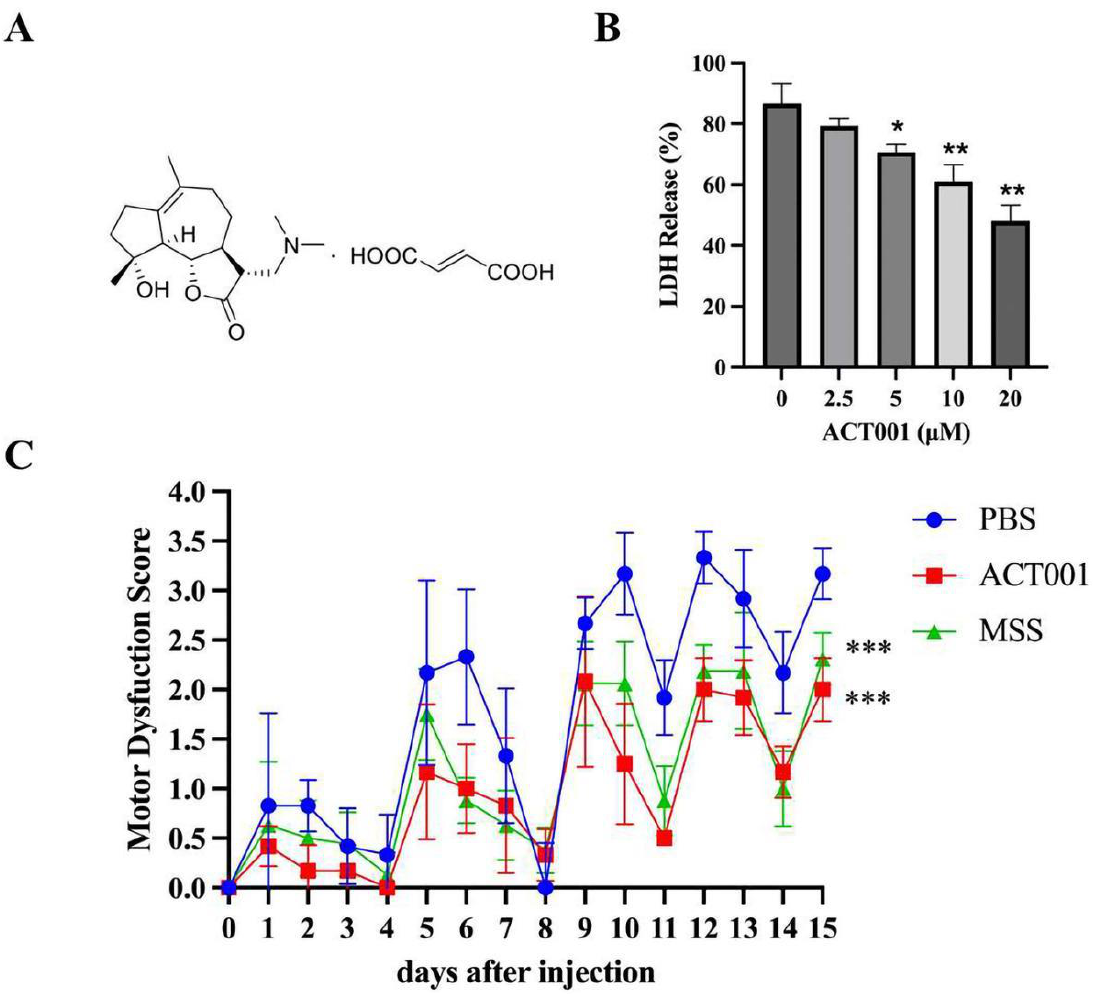
Figure 4. ACT001 reduces the damage caused by autoimmunity antibodies in vivo and in vitro. ( A ) ACT001′s chemical structure formula. ( B ) LDH release in astrocytes by AQP4-IgG with or without ACT001 treatment. * and ** represent p < 0.05, and p < 0.01, respectively. ( C ) NMOSD model behavior test of the PBS, MSS, and ACT001 treatment groups within 15 days. The significance level was expressed as follows: *** represent p <